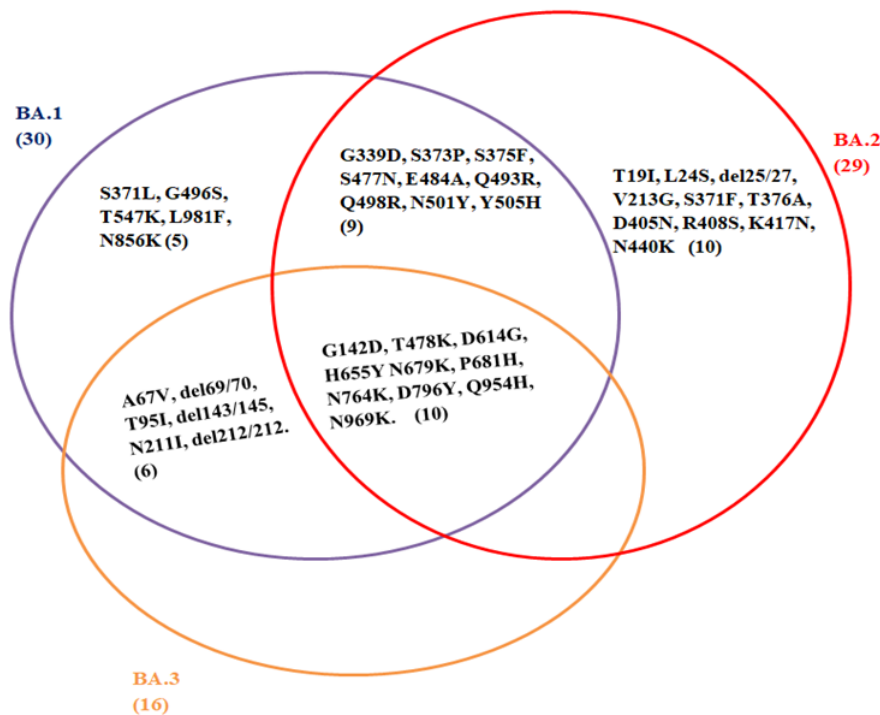
Figure 1. Comparison of spike protein mutations of Omicron sub-lineage: BA.1, BA.2, and BA.3. (GISAID: https://www.epicov.org/epi3/frontend#58aca) (accessed on 10 February 2022). This Venn diagram represents the common mutation present among the sub-linages of Omicron variant;